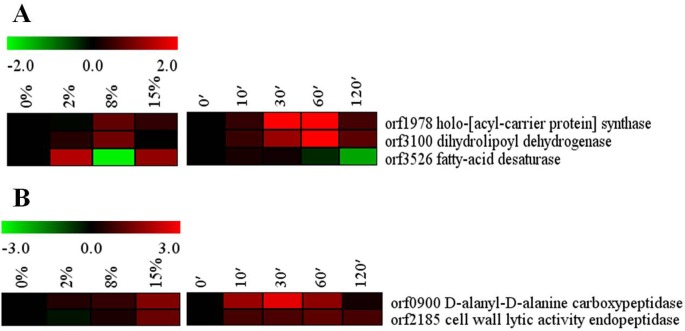
Alterations in cell envelope and cell wall related genes.(A) cell envelope related genes; (B) cell wall related genes. Expression profiles are displayed on the basis of log2 ratios.